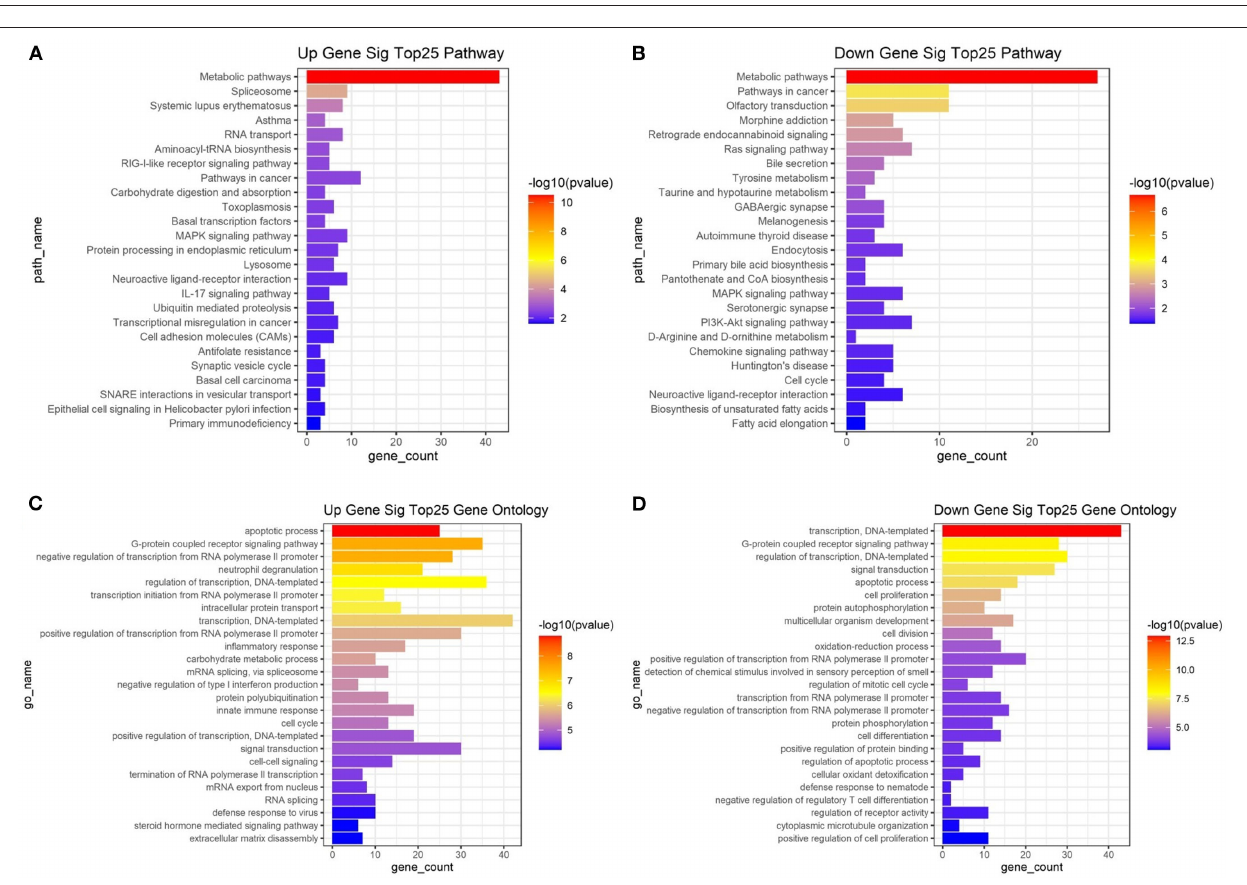
FIGURE 2 | Differentially expressed mRNAs and lncRNAs between high and low hip BMD subjects. (A,B) The heatmaps represent hierarchical clustering for differentially expressed lncRNAs and mRNAs. (C,D) Volcano plots of significantly differently expressed genes (DEGs).